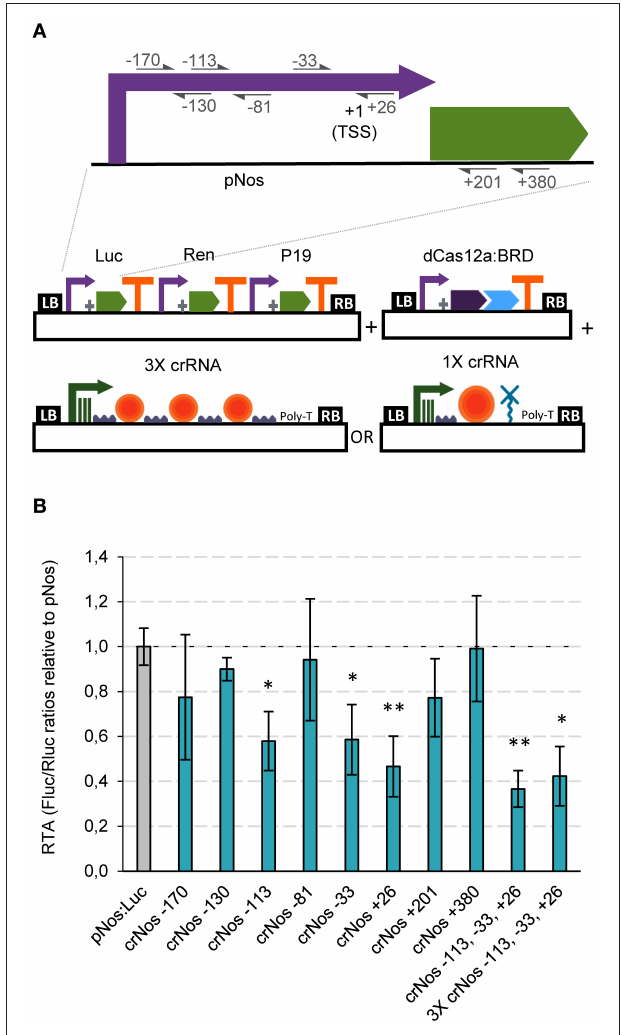
FIGURE 4 | dCas12a-based negative regulation in transient expression. (A) Schematic representation of the GB plasmids co-infiltrated for evaluating dCas12a as a tool for negative regulation of the nopaline synthase promoter. (B) Relative transcriptional activities (RTA) of the tested gRNAs in combination with the dCas12a:BRD TU and a luciferase reporter with the nos promoter. The data of bar charts represent the mean average of relative transcriptional activities (RTA) determined as Fluc/Rluc ratios of each sample normalized to Fluc/Rluc ratios of GB1116. The error bars indicate the standard deviations of all biological replicates ( n = 3). The statistical analyses were performed using unpaired t -Test. Asterisks indicate significant differences with pNos:Luc with a * P-value < 0.05 and ** P-value <